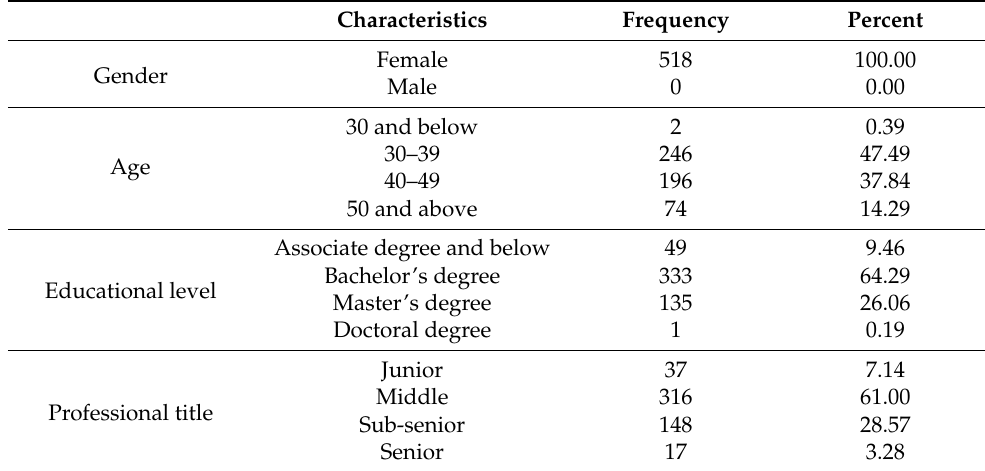
Table 1. Characteristics of the study